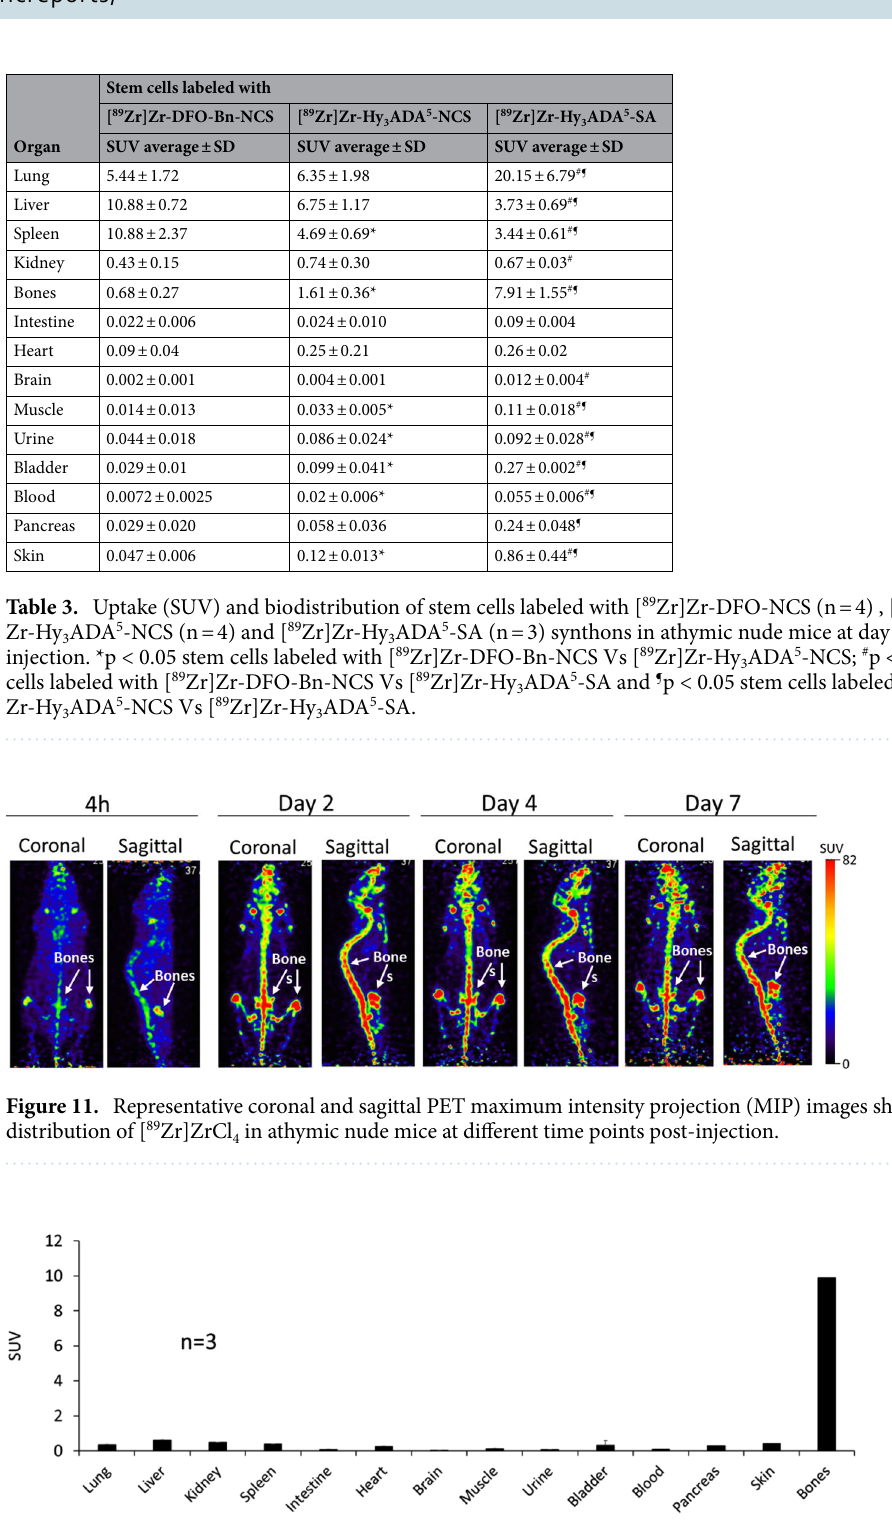
Figure 12. Uptake (SUV) and distribution of [ 89 Zr]ZrCl 4 in athymic nude mice at day 7